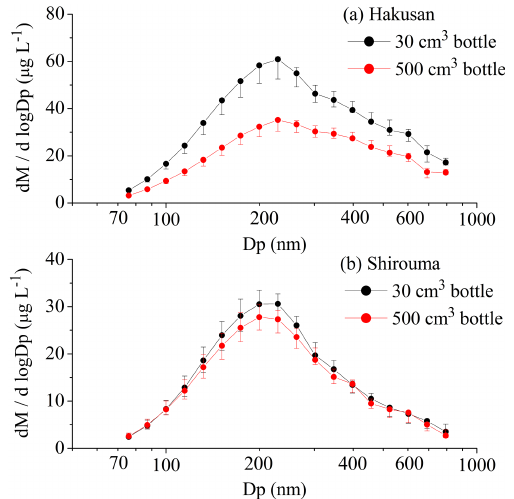
Figure 6. Size distribution of the BC mass concentration in (a) Hakusan and (b) Shirouma snow samples melted in 30cm 3 bot- tles and a 500cm 3 bottle.